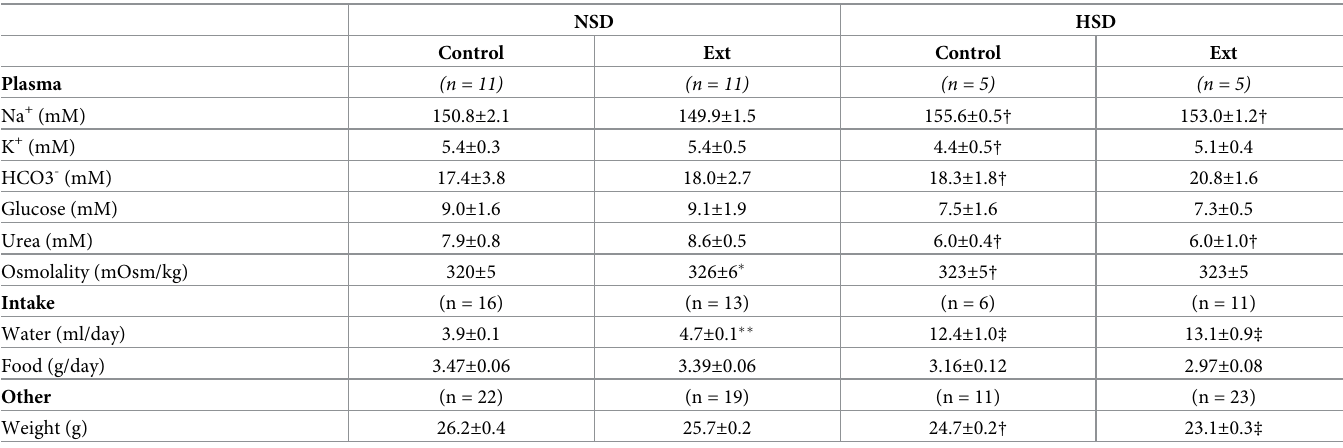
Table 1. Characteristics of Ext1 +/- Ext2 +/- and control